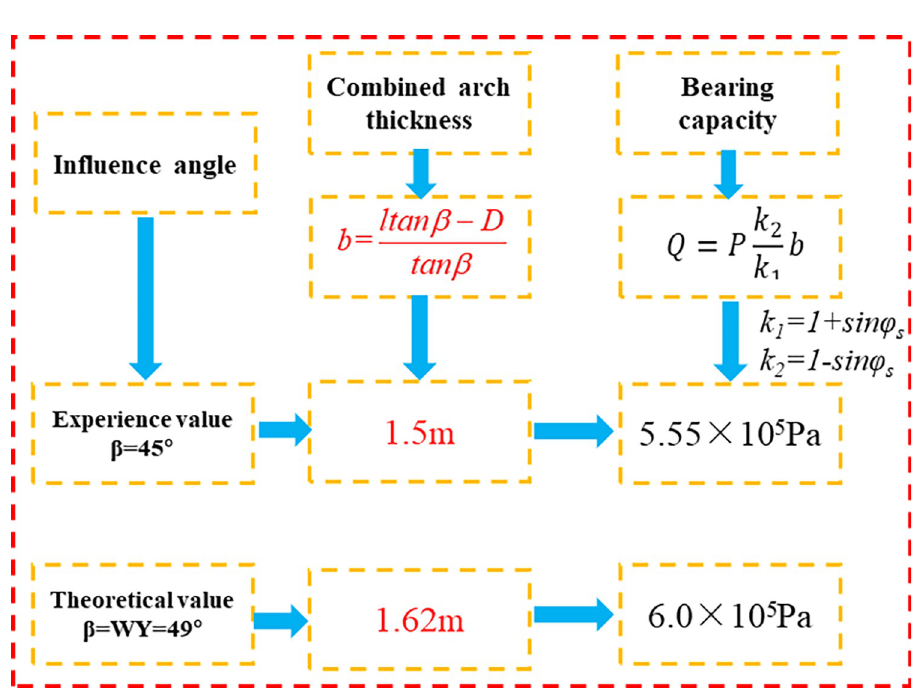
Fig 13. Comparison of empirical values and predication